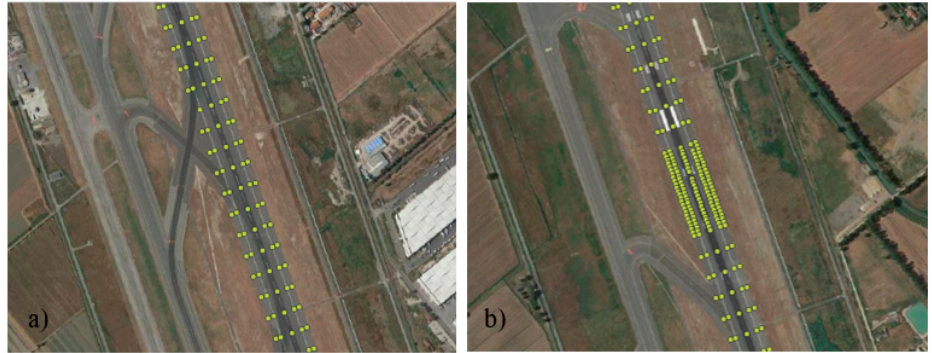
Figure 2. Scheme of in situ levelling data: ( a ) section in the middle region of Runway 3; ( b ) increase in measuring points density on the ground in the area interested by subsidence effects .